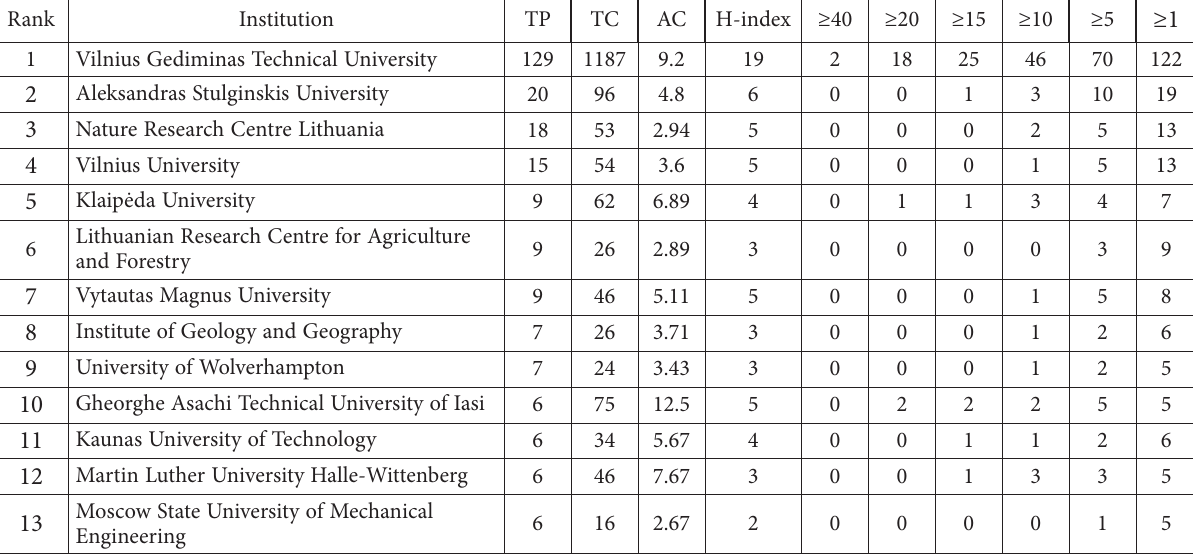
Table 5. The top 13 most influential institutions of the JEELM publications